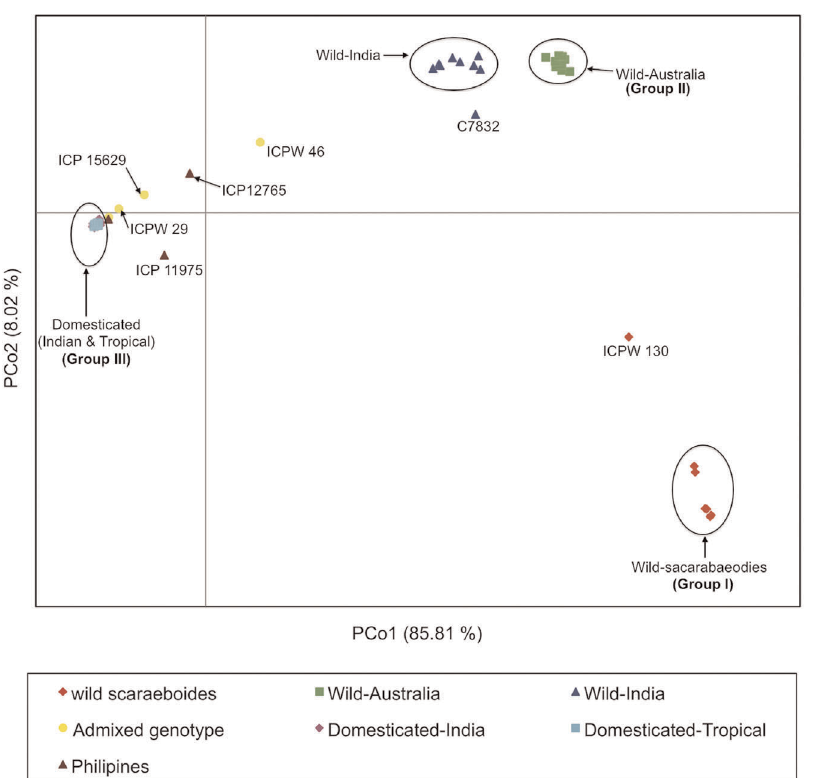
Figure 3. Principal coordinates analysis of domesticated pigeonpea and wild relatives. Red diamonds, wild C. scarabaeoides ; green squares, wild-Australia Cajanus spp; dark blue triangles, wild-India Cajanus spp; light blue squares and pink diamonds represent domesticated C. cajan of tropical and Indian origin, respectively. Admixed genotypes between domesticated and wild species are labeled with yellow circles, or in the case of admixed Philippines accessions with dark red triangles. Accession numbers were added for accessions mentioned in the text.